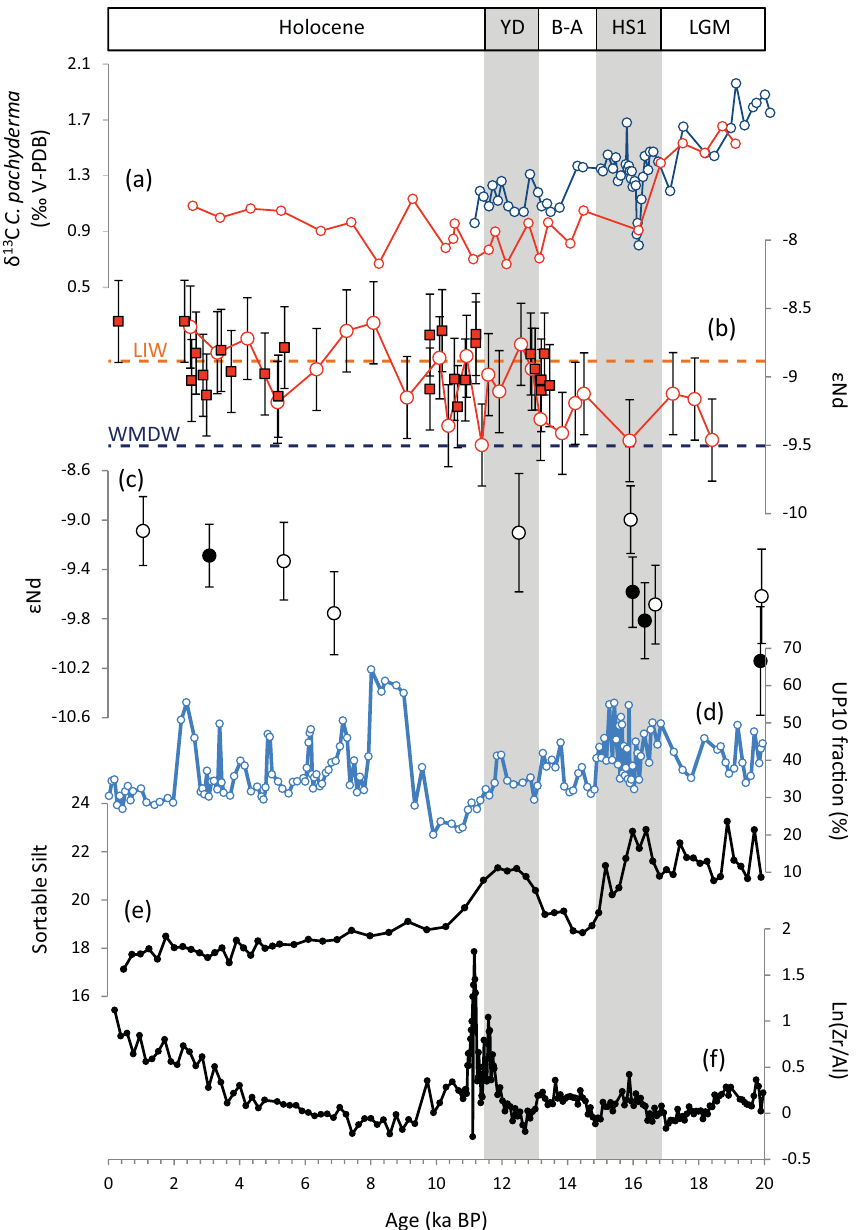
Figure 4. (a) δ 13 C records obtained on benthic foraminifer C. pachyderma for cores SU92-33 (red line) and MD99-2343 (blue line; Sierro et al., 2005). (b) ε Nd records obtained on mixed planktonic foraminifers from core SU92-33 (open circles) and from cold-water coral fragments collected in the Alboran Sea (red squares). Modern ε Nd values for LIW (orange dashed line) and WMDW (blue dashed line) are also reported for comparison. (c) ε Nd values obtained for planktonic foraminifera with Fe–Mn coatings at sites 300G (36 ◦ 21.532 (cid:48) N, 1 ◦ 47.507 (cid:48) W; 1860m; open dots) and 304G (36 ◦ 19.873 (cid:48) N, 1 ◦ 31.631 (cid:48) W; 2382m; black dots) in Alboran Sea (Jimenez-Espejo et al., 2015). (d) UP10 fraction (>10µm) from core MD99-2343 (Frigola et al., 2008). (e) Sortable silt mean grain size of core MD01-2472 (Toucanne